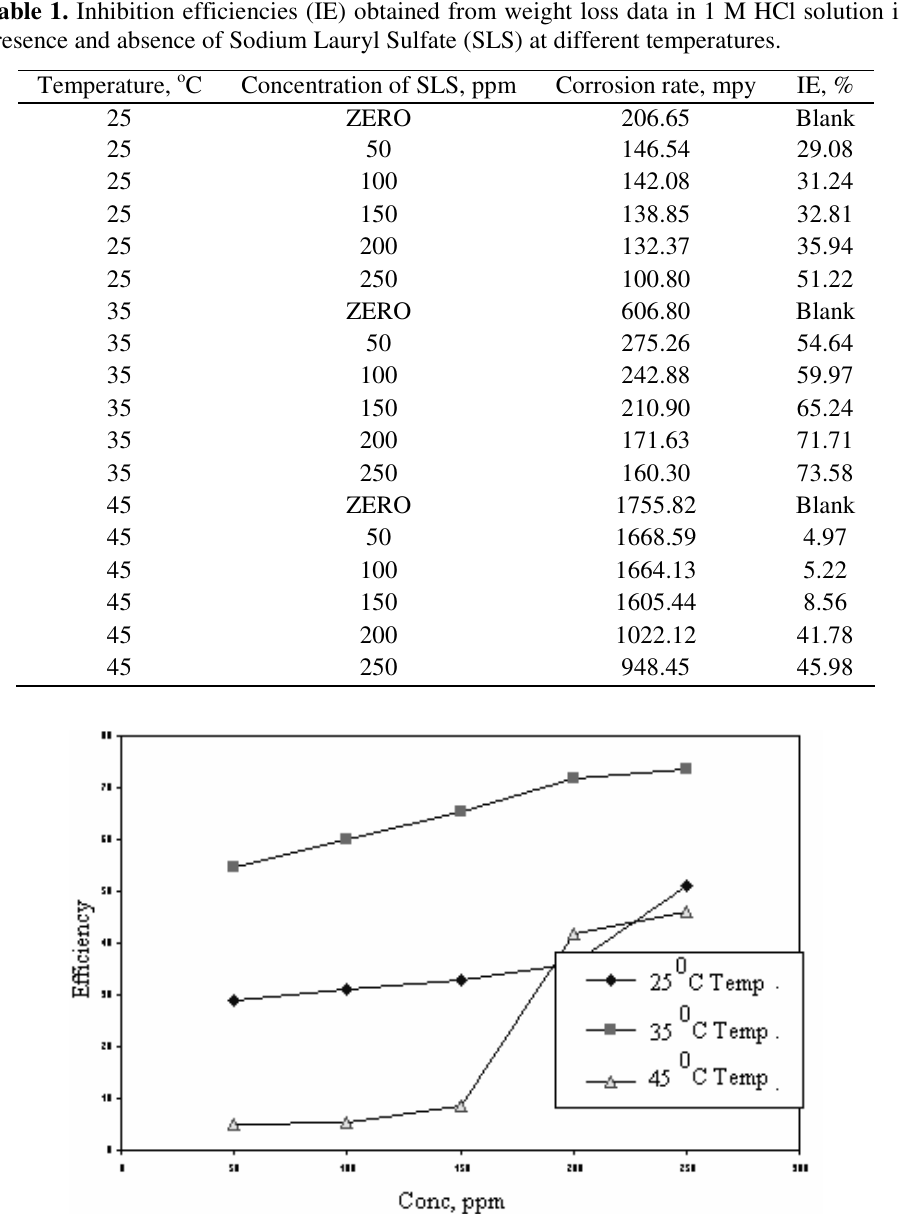
Figure 1. Variation of percentage inhibition efficiency with SLS